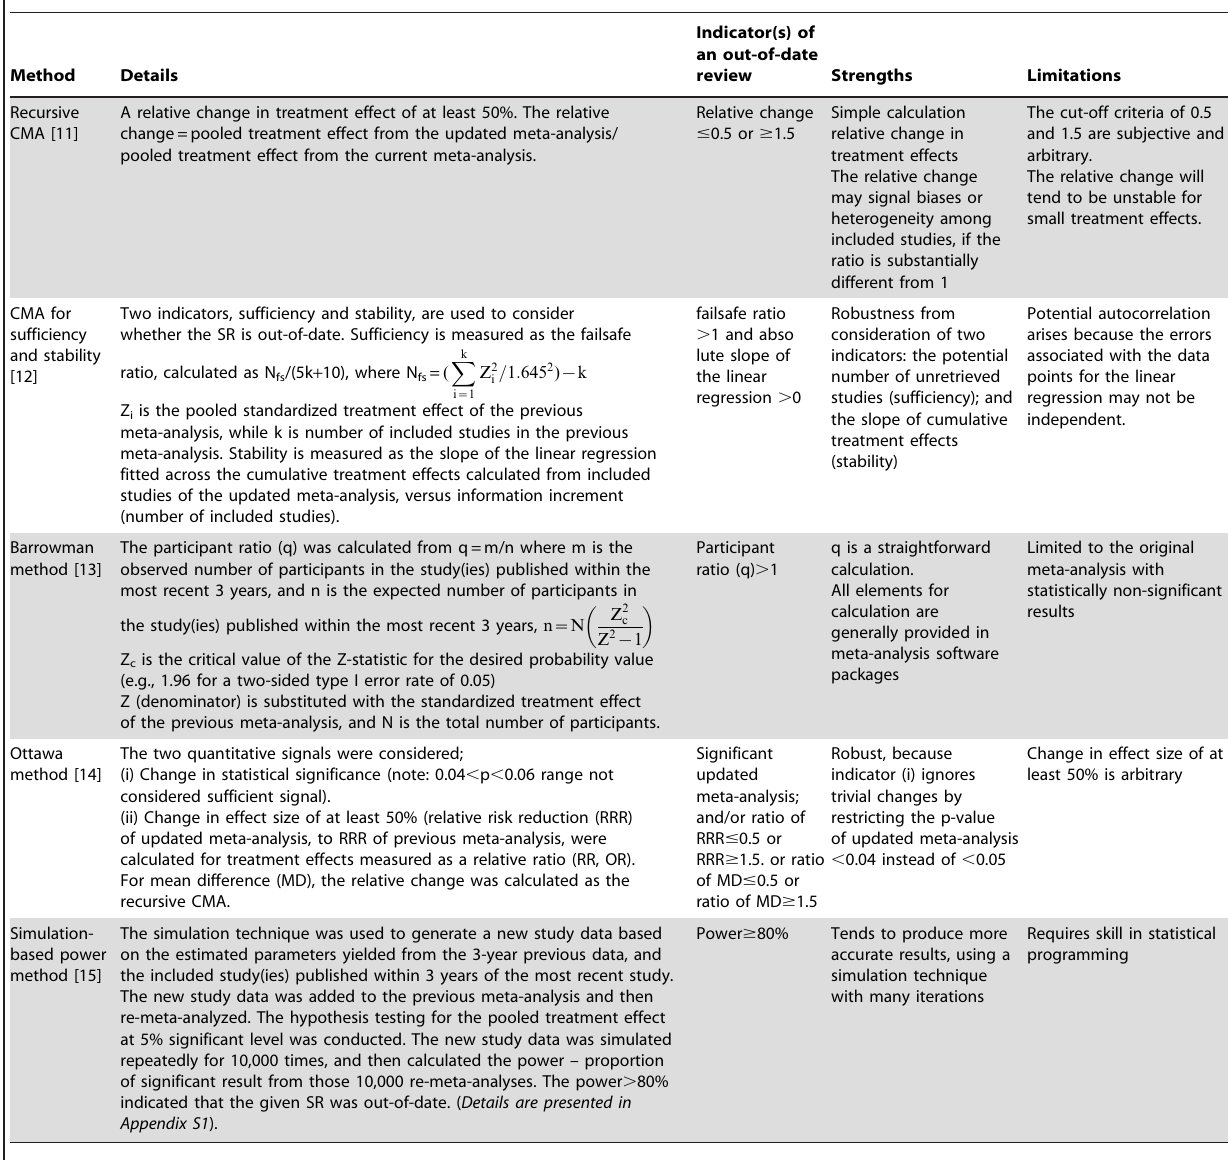
Table 1. Five statistical methods for identifying out-of-date